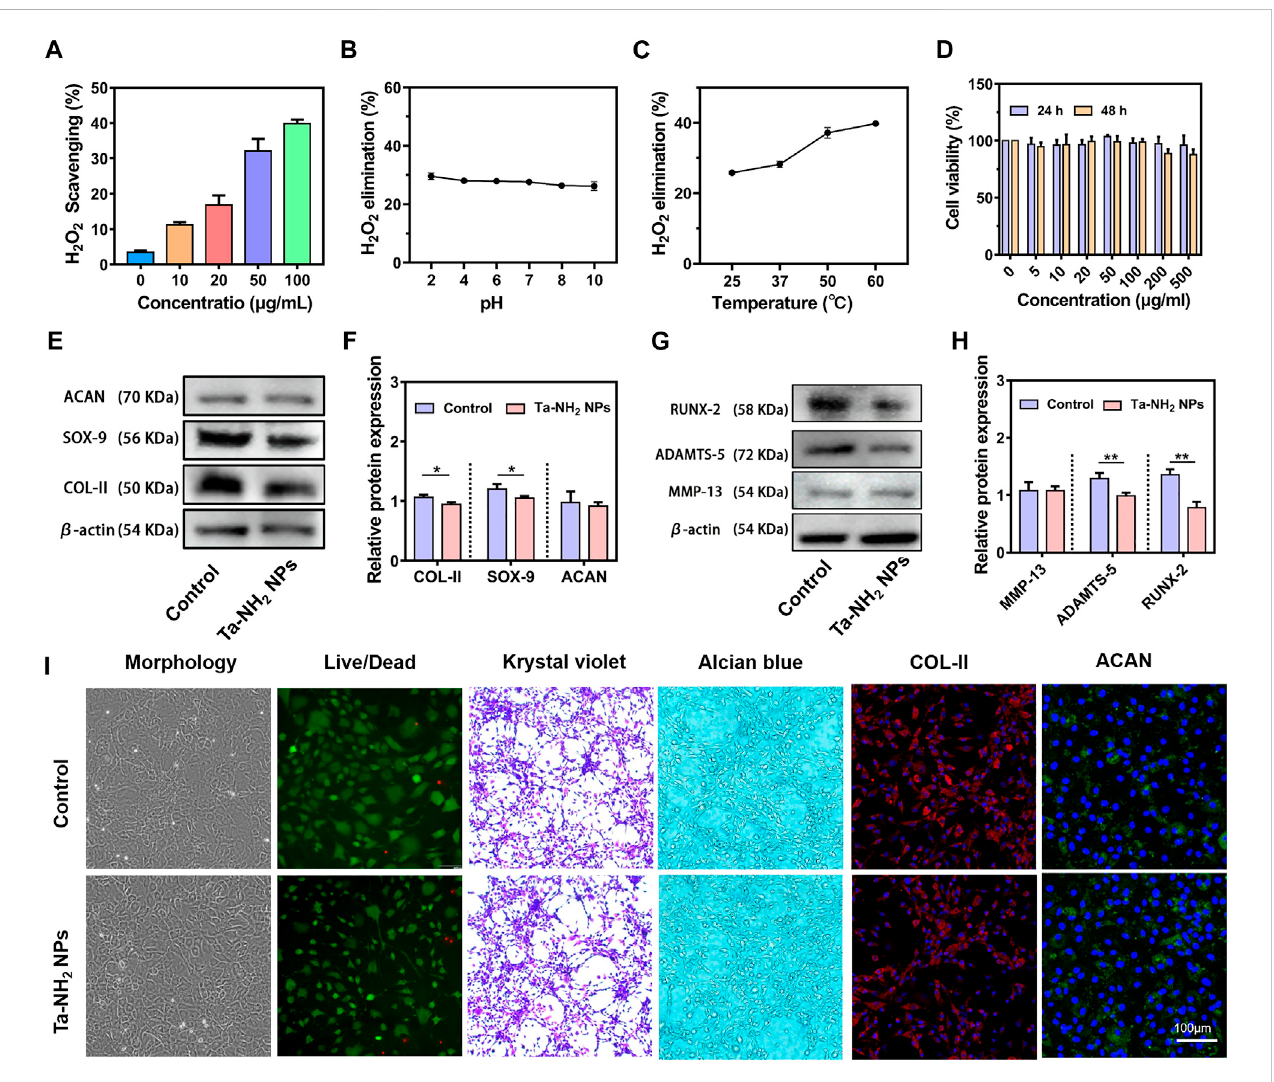
FIGURE 3 H 2 O 2 scavenging activity and in vitro biocompatibility of Ta-NH 2 NPs. (A) Concentration dependent H 2 O 2 scavenging activity of Ta-NH 2 NPs during 1 h incubation. (B) pH and (C) temperature stabilities of H 2 O 2 scavenging activity in Ta-NH 2 NPs (100 μ g/mL). (D) Chondrocyte viability under different Ta-NH 2 NPs concentration treatments. (E,F) Western blot analysis of hyaline (COL-II, SOX-9, and ACAN), (G,H) hypertrophic and catabolic (MMP-13, RUNX-2, and ADAMTS-5) phenotypes of chondroyte after 24 h of Ta-NH 2 NPs treatment. (I) Morphology, Live/Dead Krystal violet, Alcian blue, and COL-II/ACAN immuno fl uorescence staining of chondrocytes treated with Ta-NH 2 NPs. Data were represented as means ± s.d, from three independent replicates. ** p <